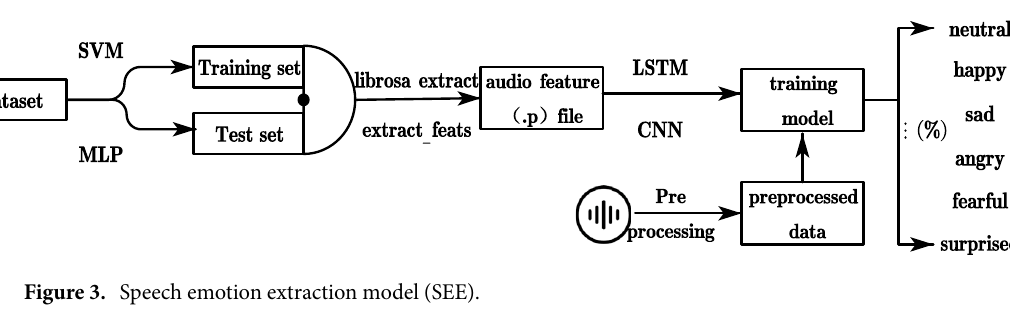
Figure 2. Schematic diagram of the dual subjective and objective mental health testing system.